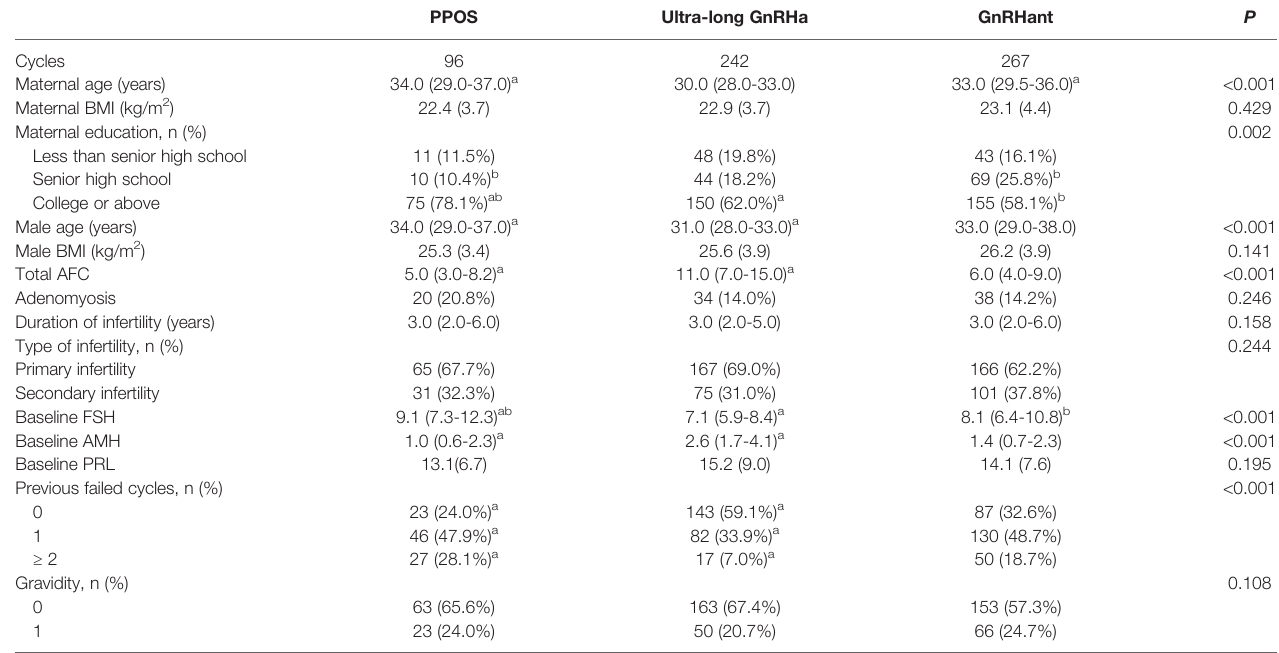
TABLE 1 | Baseline characteristics of the participants in the three